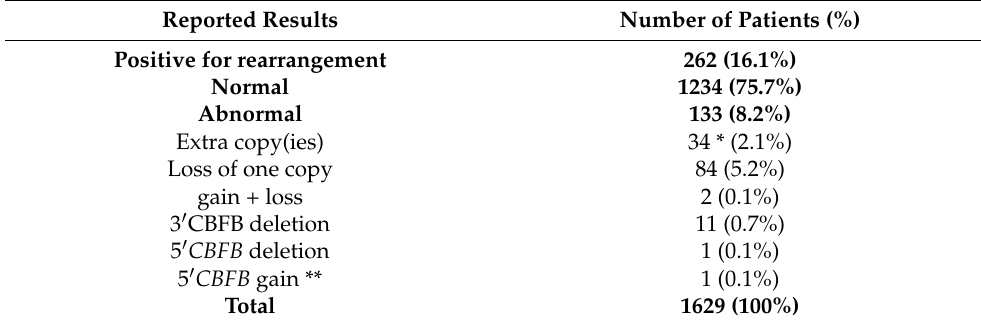
Figure 2. CBFB BAP FISH demonstrated that 3 ′ CBFB signal (green) was translocated on an abnormal chromosome 1 ( A) . Case #1 and an abnormal chromosome 19 ( B) . Case #3, respectively. From left to right: metaphase FISH image with DAPI; inverted metaphase FISH image to show chromosome morphology; affected chromosomes and their normal homologs. Red: 5 ′ CBFB ; Green: 3 ′ CBFB; Fusion (yellow) : intact CBFB.